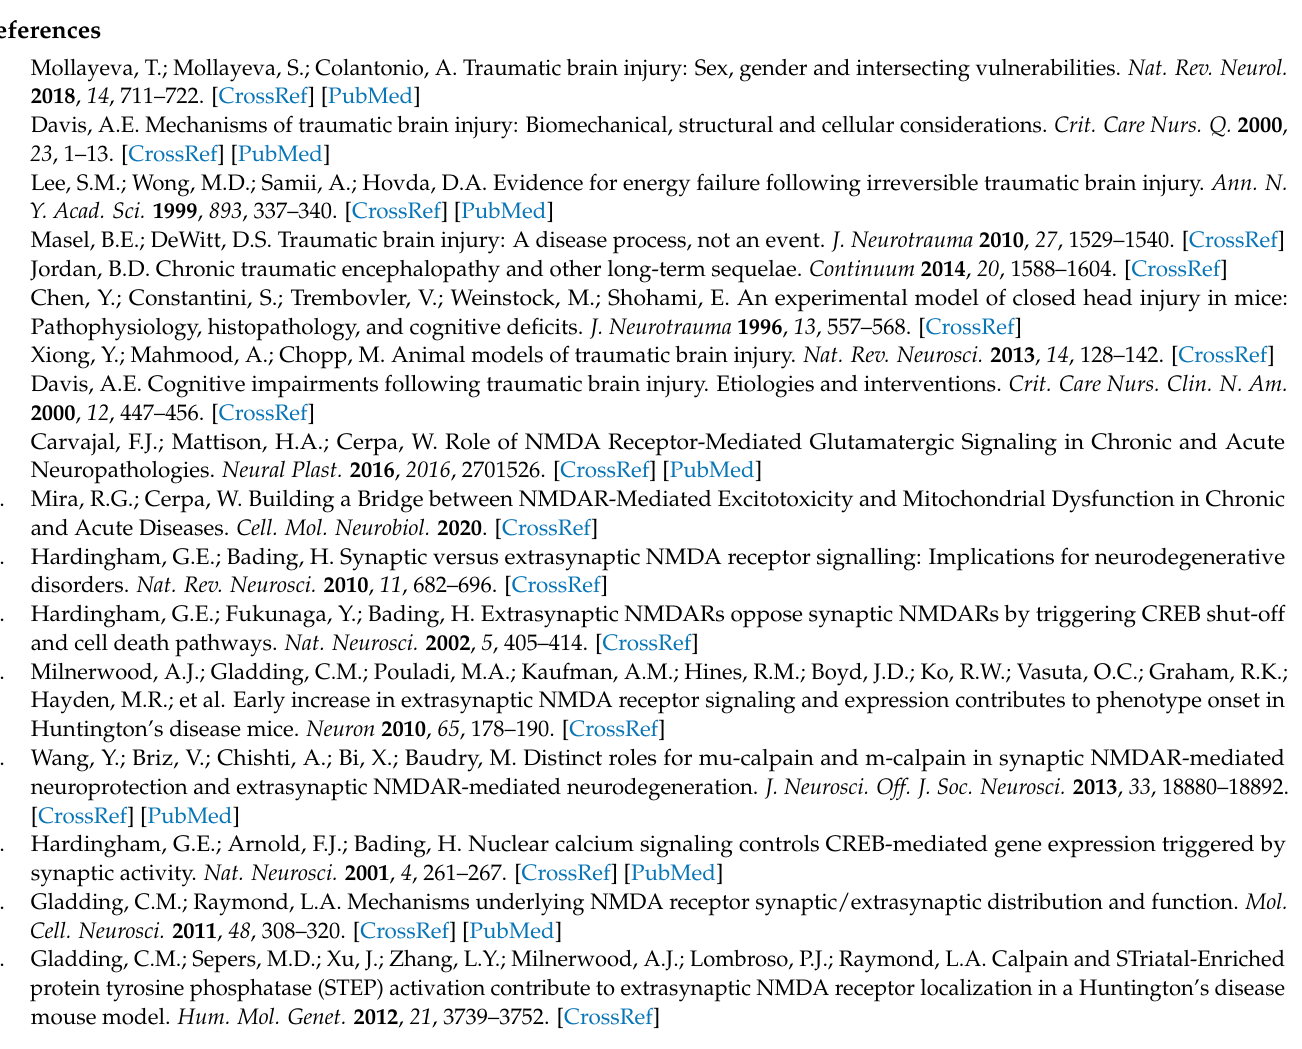
Figure S2. Neurologic features after TBI induction. Table S1. List of antibodies used for western-blot analysis and immunofluorescence studies. Table S2: Neurological function scoring